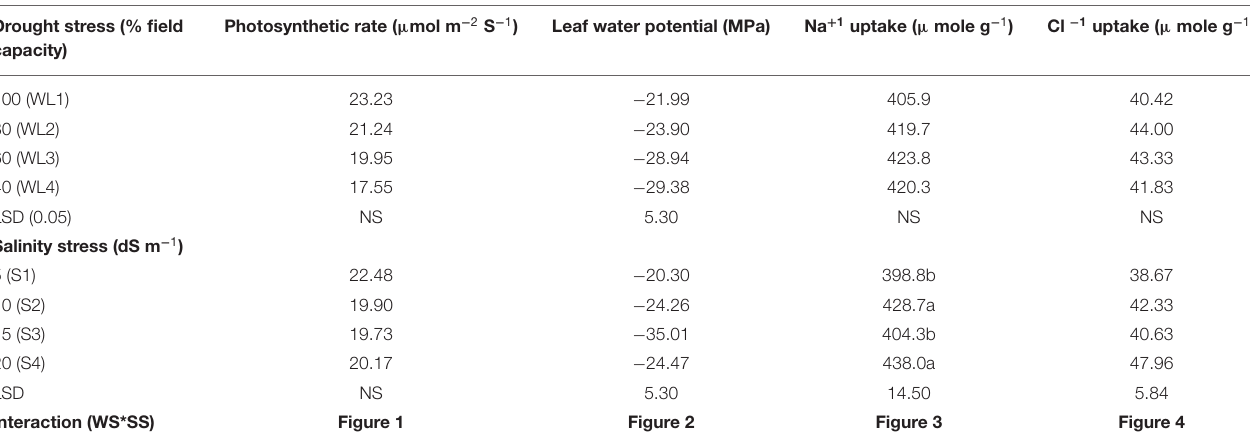
Table 3 | Physiological response of S. imbricata to varying drought and salinity